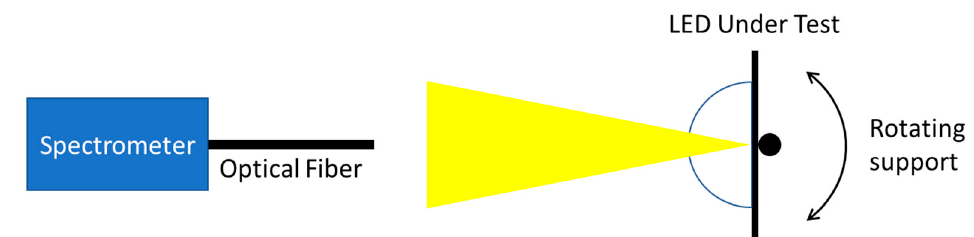
Figure 3. Top view schematic of our setup to measure the emitted radiation pattern.